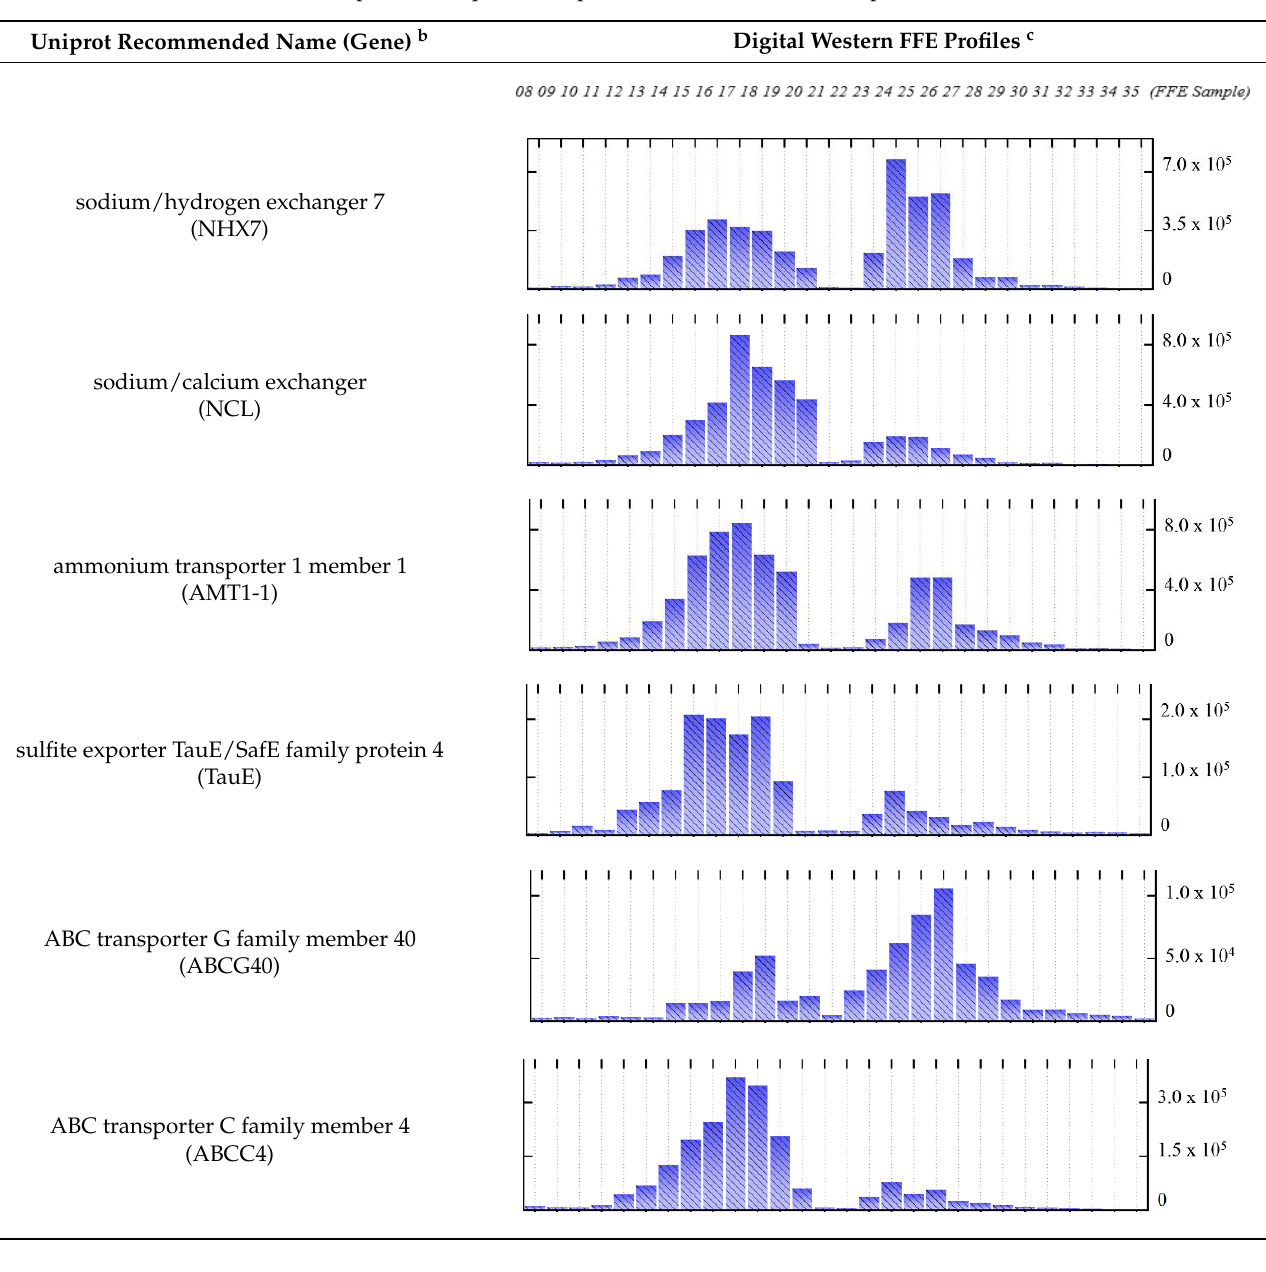
Table 7. Unexpected FFE profiles of proteins known to localize to plasma membrane a .